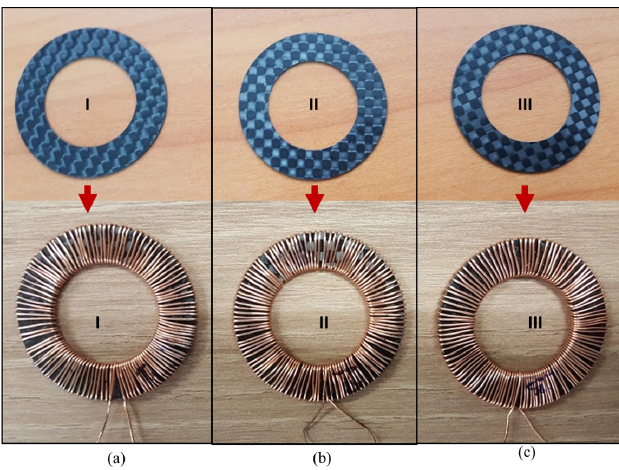
Figure 5. Inductors with CFRP-FeSi core: ( a ) CF-FeSi-1; ( b ) CF-FeSi-3 and ( c ) CF-FeSi-3.